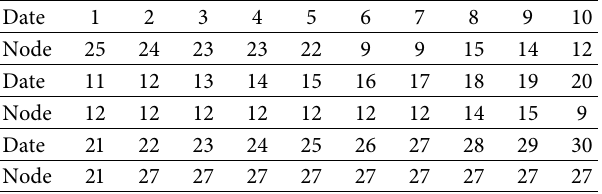
Table 8: The best strategy of the second situation in Level 1.